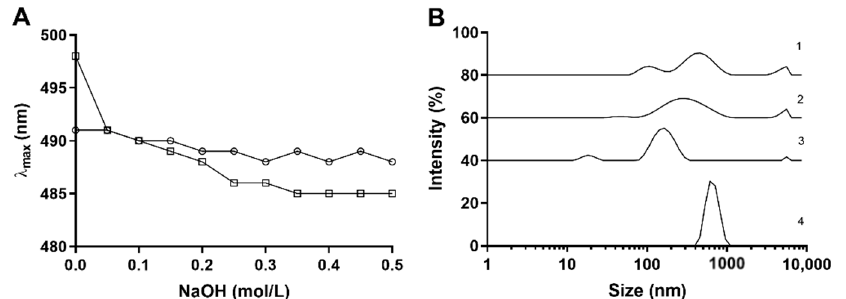
Figure 4. Tertiary structure characterization of As sP. ( A ) The maximum absorbance wavelength of Congo-red (square) and Congo-red As sP mixture (circle) solution as the NaOH concentration changes. ( B ) The dynamic light scattering intensity of As sP solution as a function of the cumulative mean diameter at each purification step: 1, water extraction; 2, after ethanol precipitation; 3, after pectin removal; 4, after gel filtration